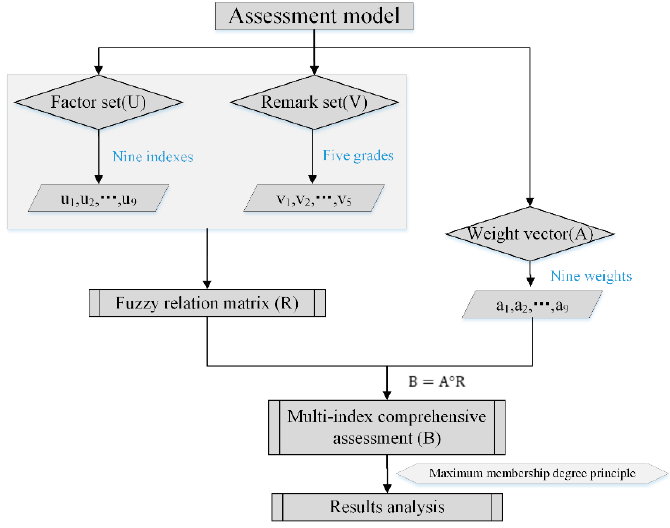
Figure 3. Framework diagram of the fuzzy comprehensive assessment model.